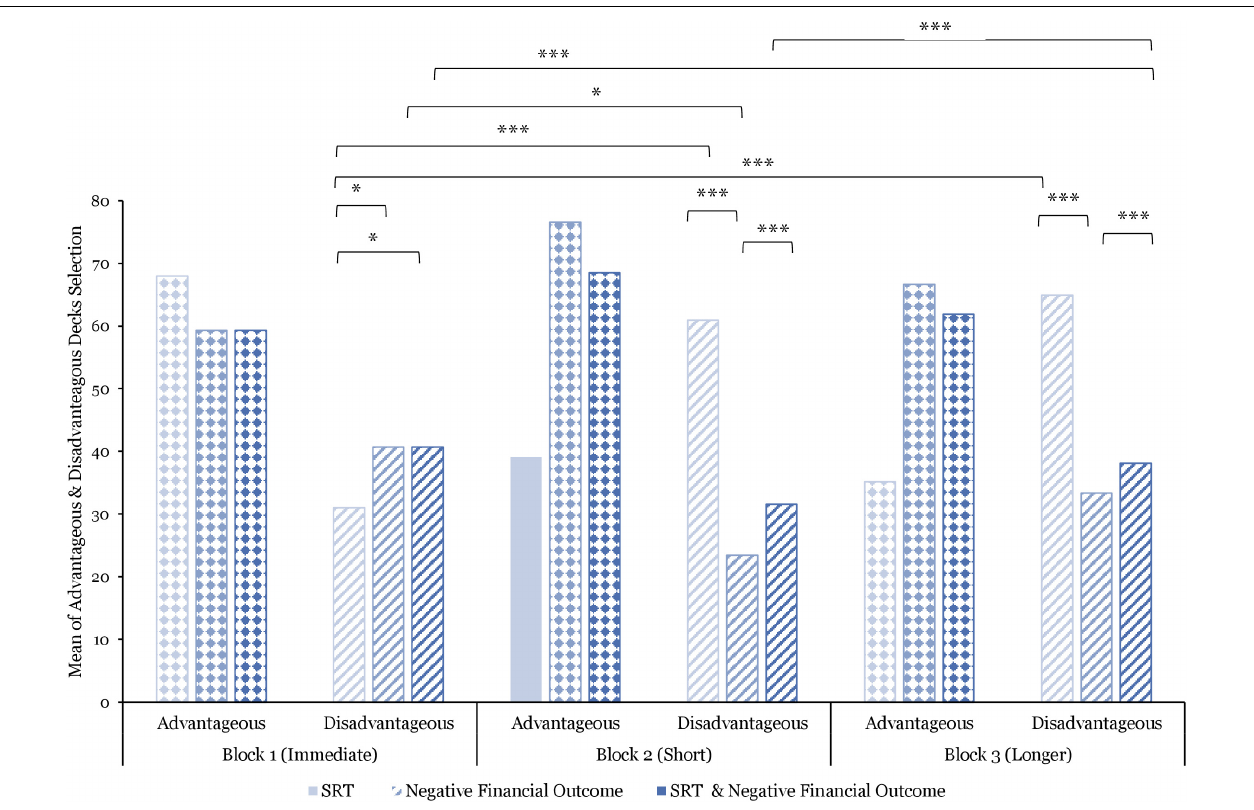
FIGURE 11 | Comparisons of mean advantageous and disadvantageous decks selected by stress manipulations and by blocks. Significant differences are marked as ∗ p < 0.05; ∗∗∗ p < 0.001. TABLE 2 | Correlations between perceptual